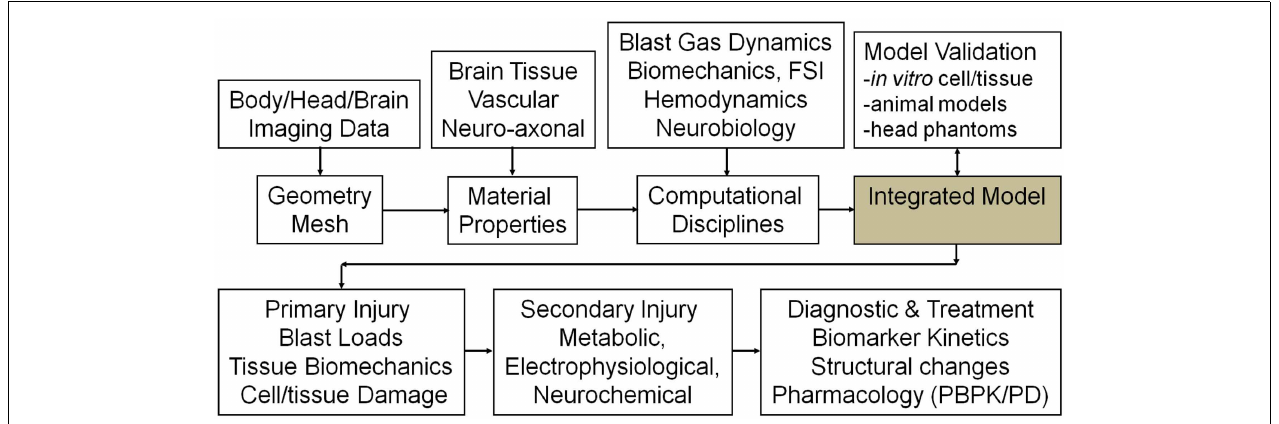
FIGURE 6 | Schematic of the simulation framework, tools and interfaces, and expected results